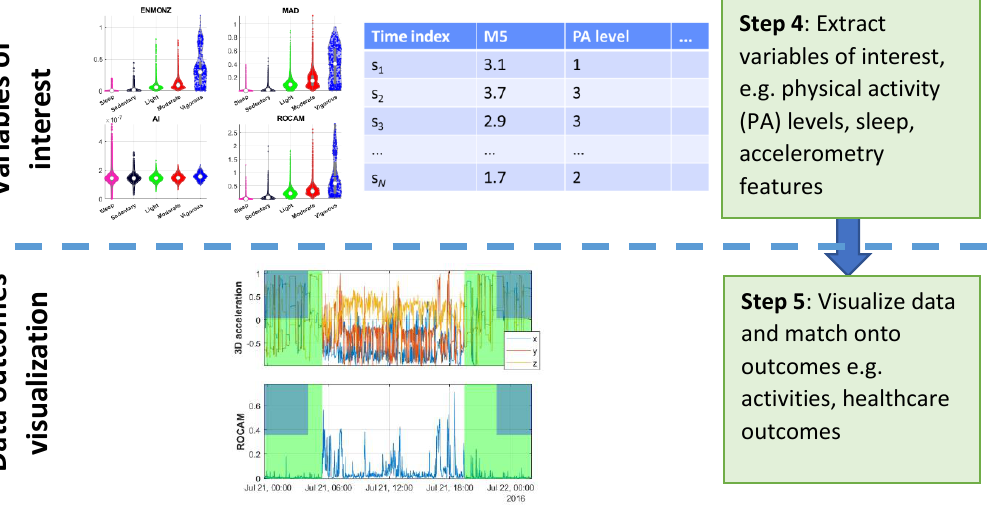
Figure 1. Flowchart with an overview of the methodology used in the study (Steps 2–4) and how it could be deployed in more generic applications, e.g., with healthcare outcomes (Step 5), including sleep-related outputs (see